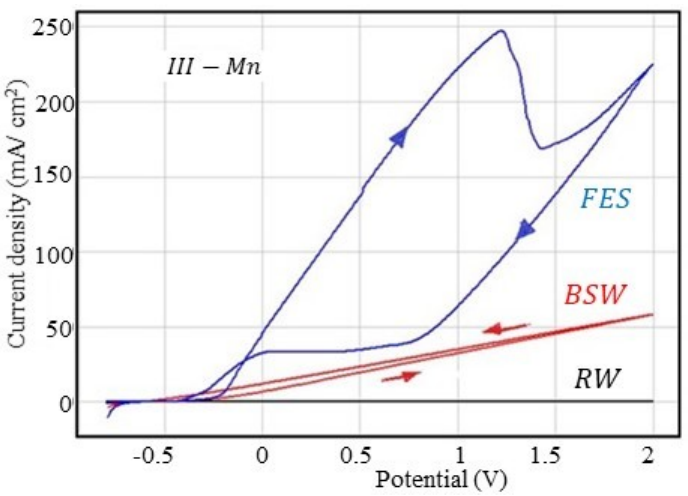
Figure 4. Cyclic voltammograms for the III-Mn sample.